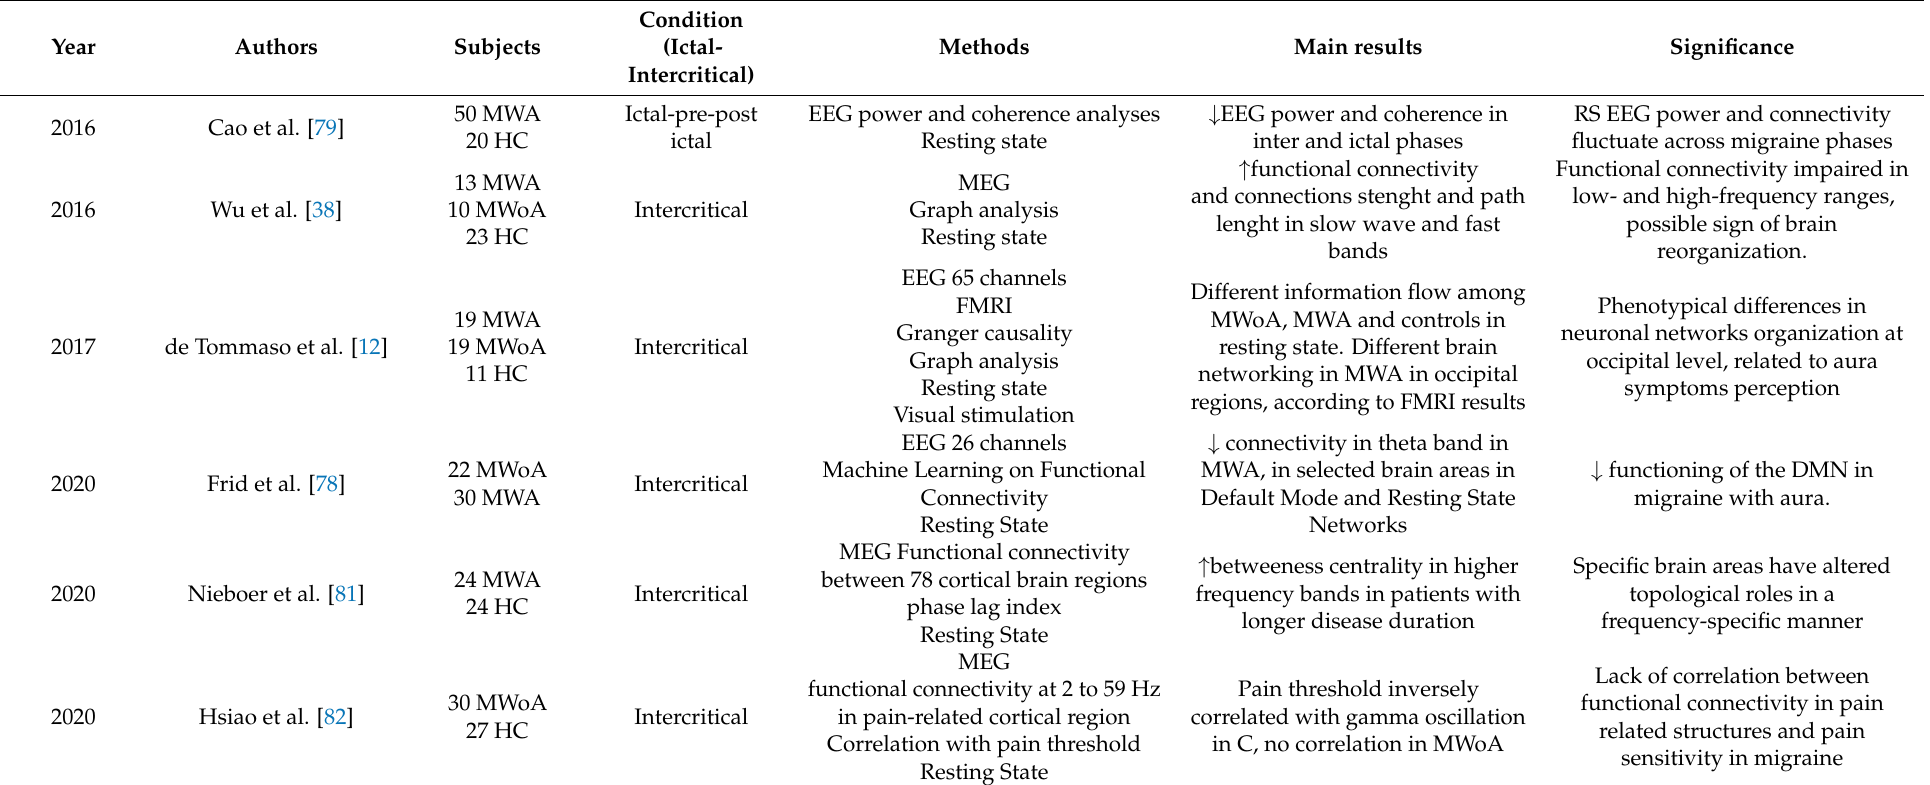
Table 3. Resting state and Pain stimulation-related EEG/MEG connectivity